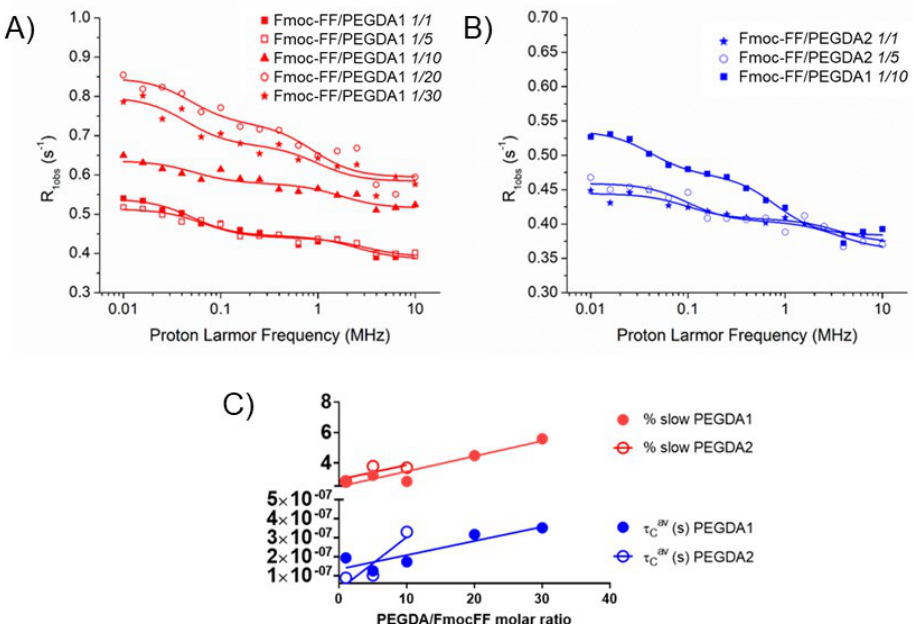
Figure 2. 1 H NMRD profiles measured on HGs with PEGDA1 ( A ) and PEGDA2 ( B ) at 298 K. Continuous lines represent the best fits obtained with a sum of Lorentzian functions. ( C ) Variation of the average water correlation time ( τ ca υ ) and the percentage of slowing moving water (% slow) as a function of PEGDA molar content. Table 2. Parameters obtained through fitting of the 1 H-NMRD profiles.